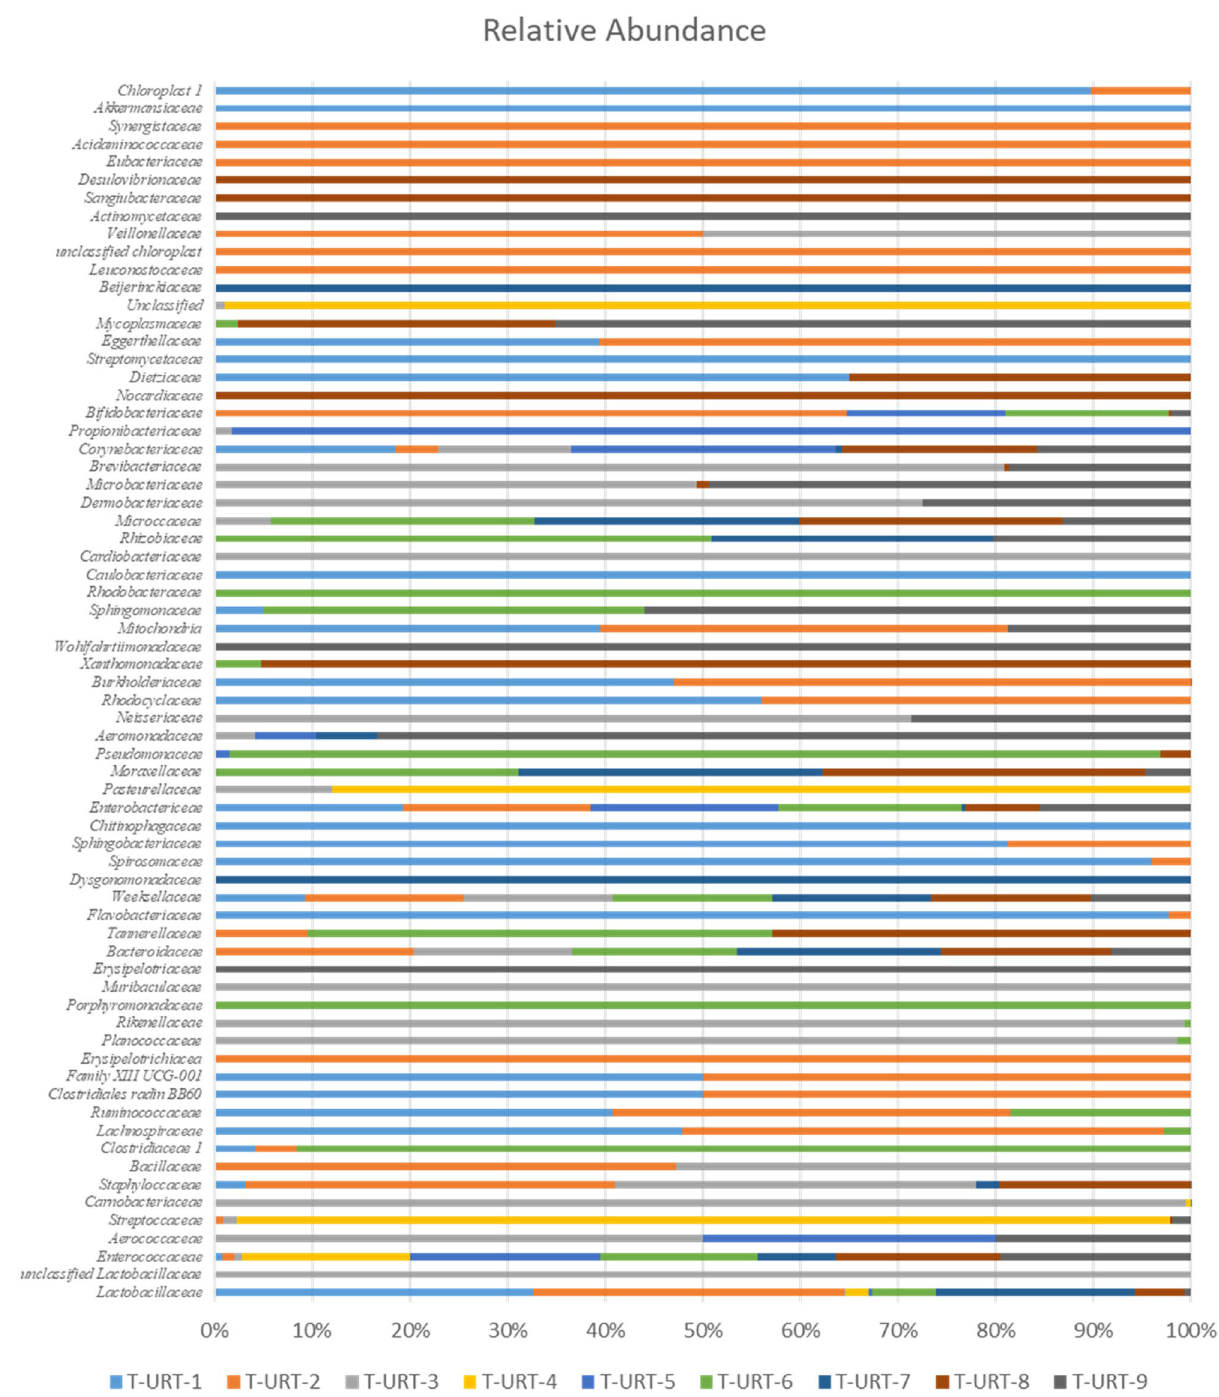
Figure 2. Taxonomic diversity plot showing the relative abundance of taxa at the family level in each